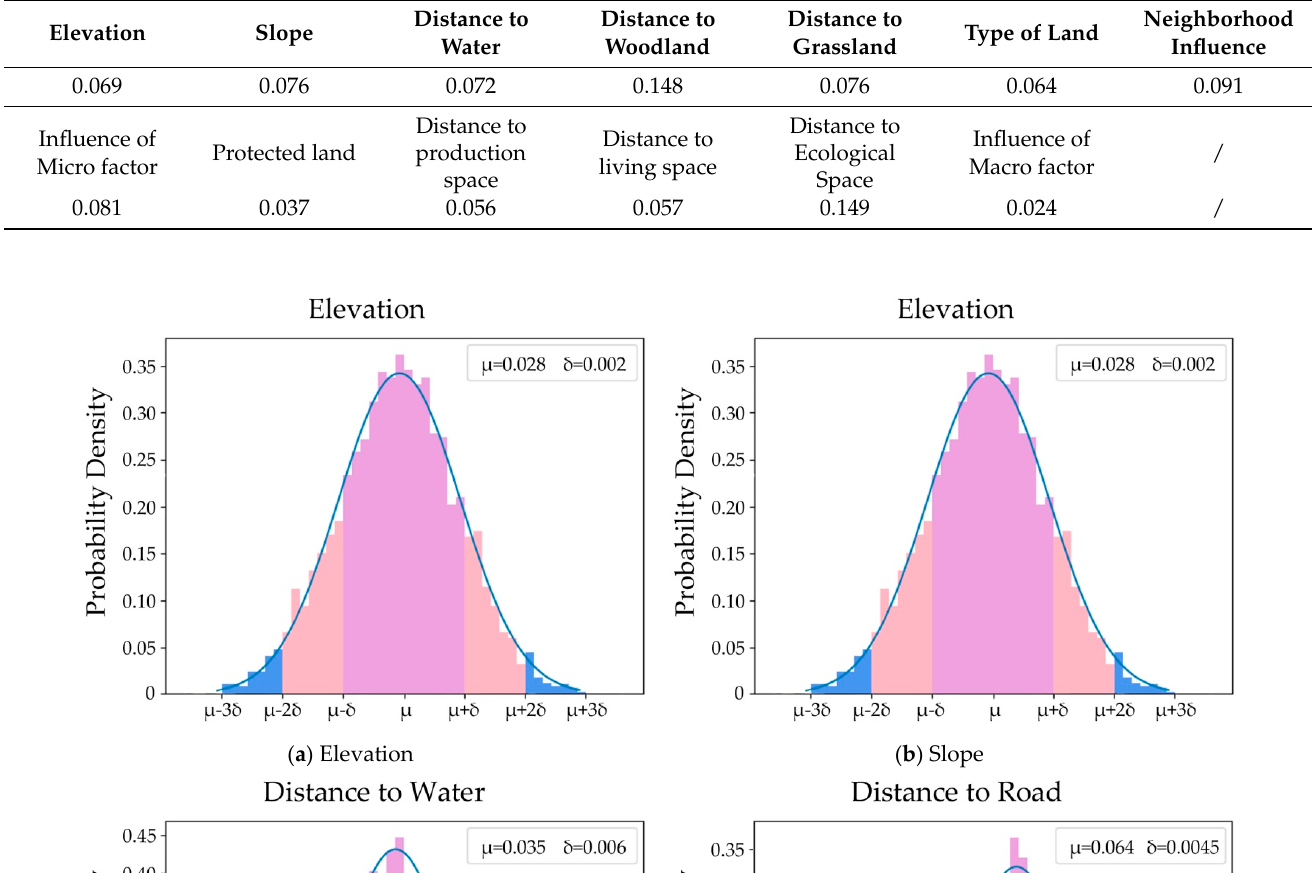
Table 7. Initial weight determination results of factors in ecological space evolution simulation.